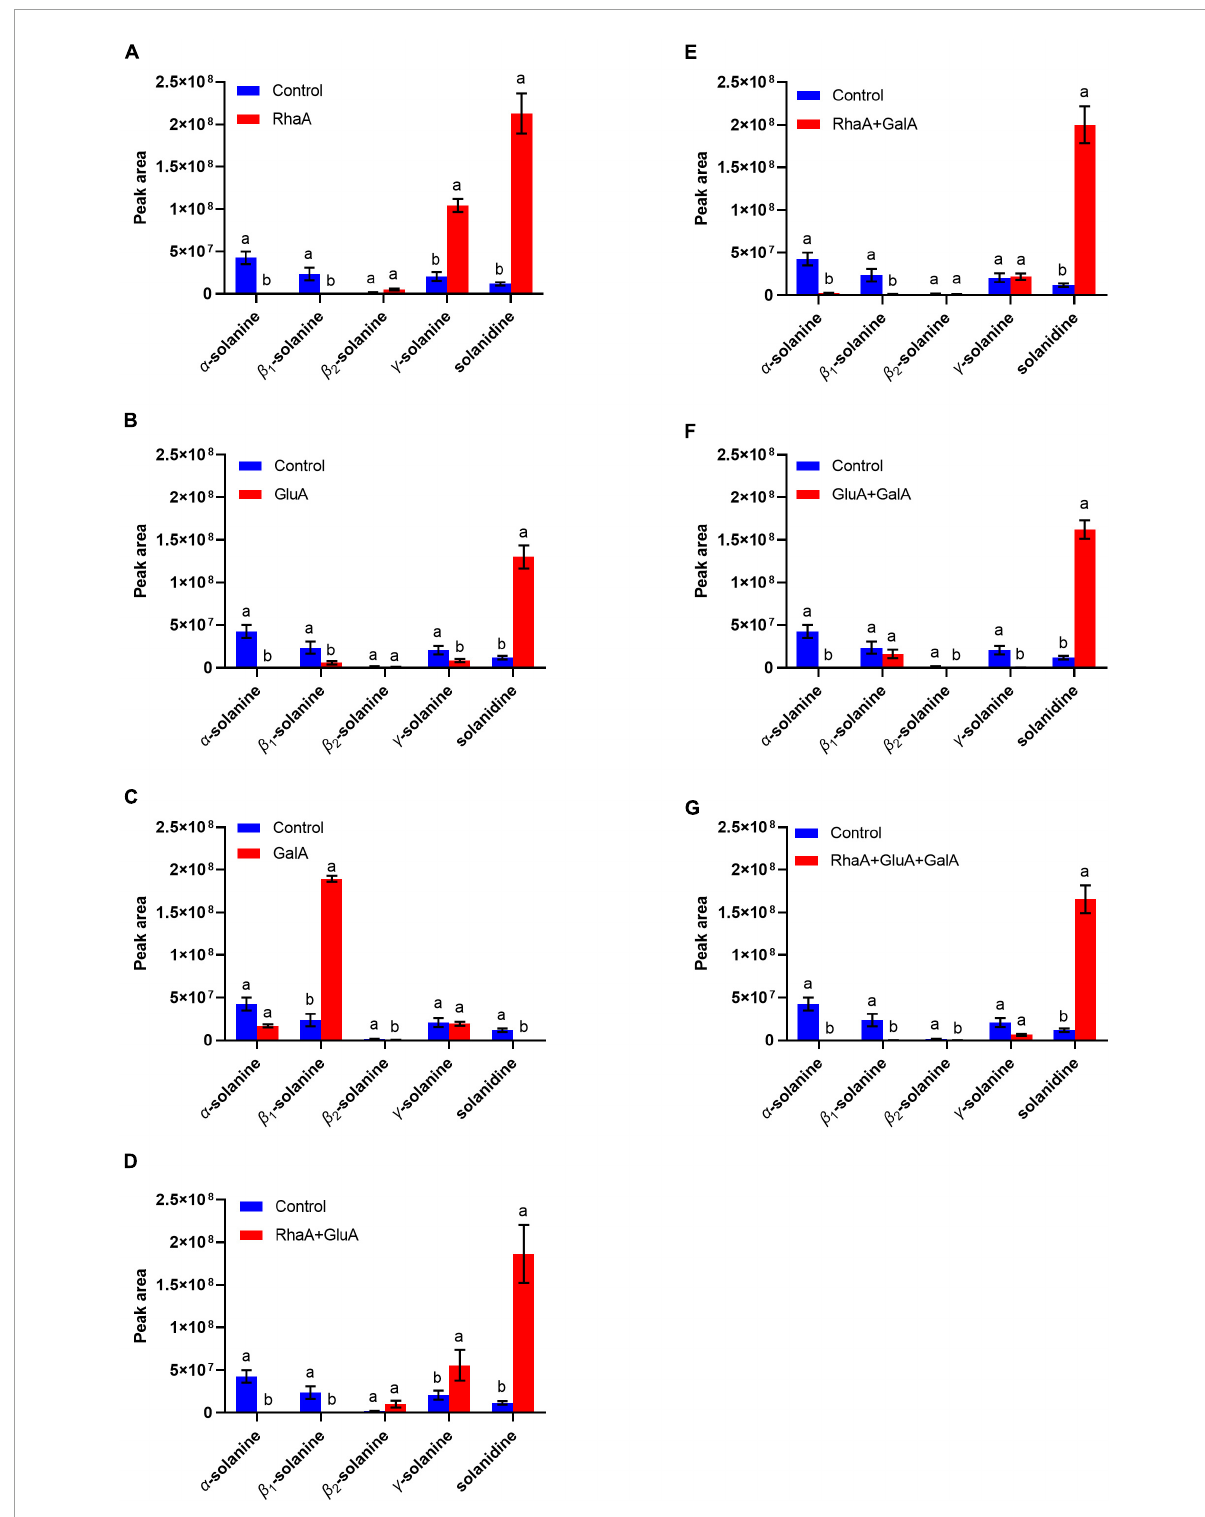
FIGURE3 Hydrolysis products released from α -solanine standards by the action of recombinant enzymes of (A) RhaA; (B) GluA; (C) GalA; (D) RhaA + GluA; (E) RhaA + GalA; (F) GluA + GalA; (G) RhaA + GluA + GalA. Bars (mean ± SD) labeled with different letters within each treatment are significantly different ( P < 0.05, independent-sample t -tests, n =